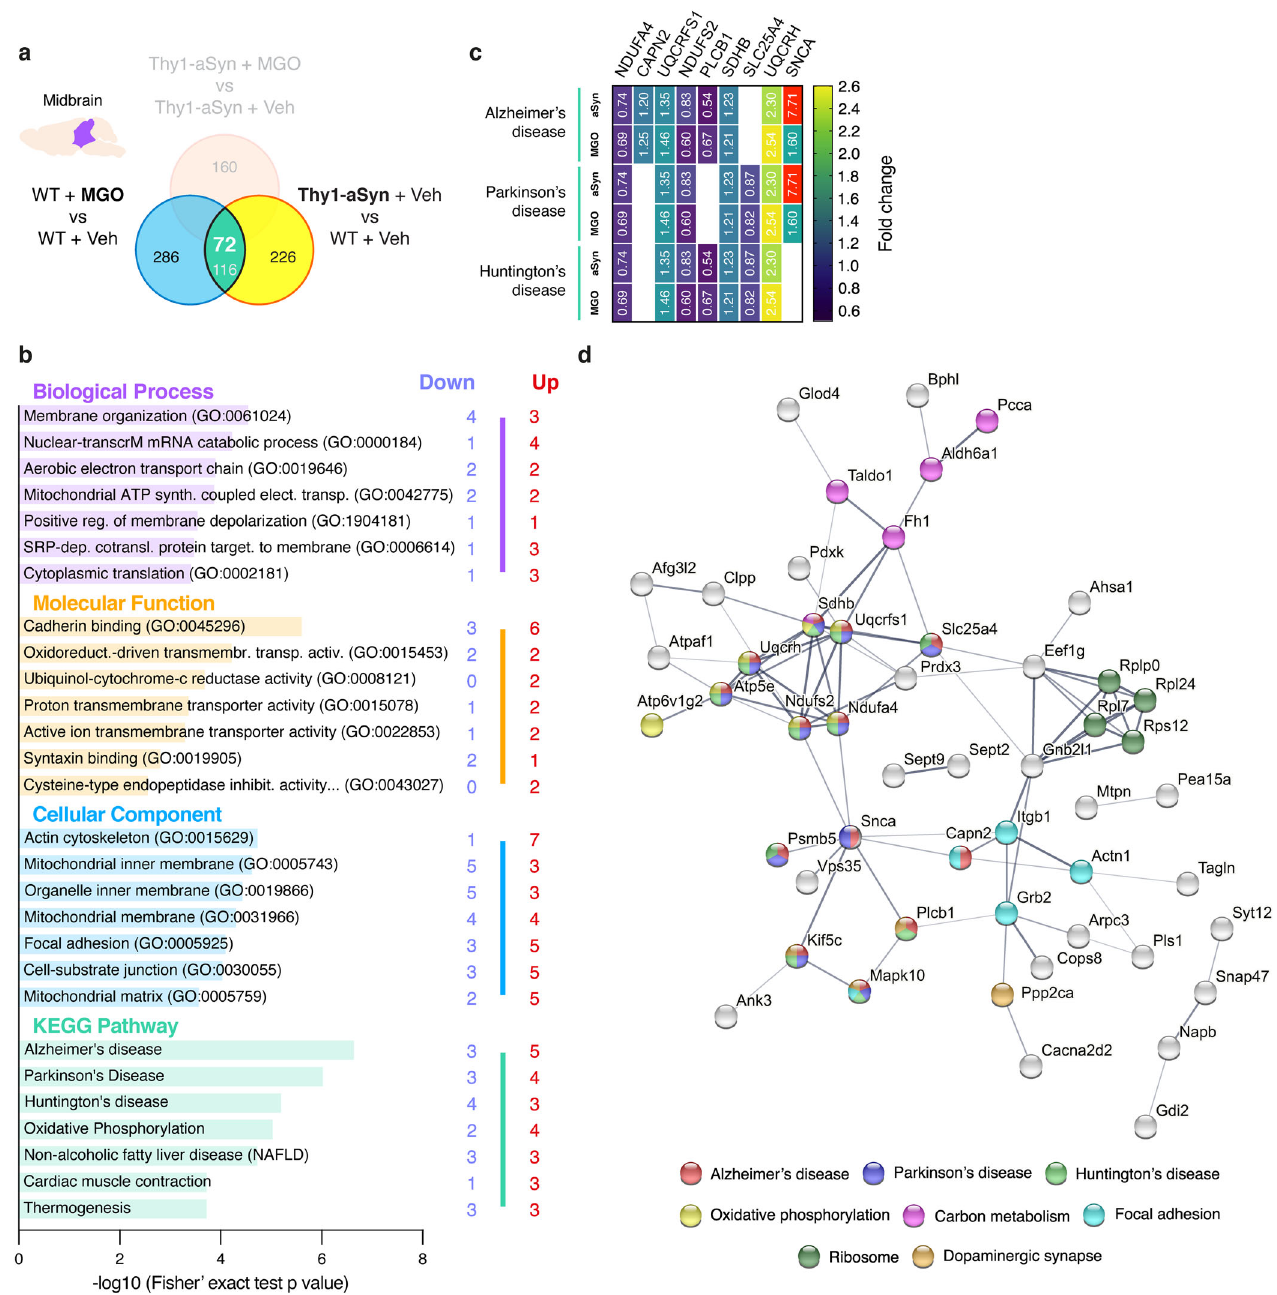
Fig. 8 MGO-treatment and aSyn overexpression similarly alters neurodegenerative- and oxidative phosphorylation-associated components in the midbrain. Proteomic differences between midbrain proteins from WT or Thy1-aSyn mice injected with vehicle or MGO. a Venn diagram depicting midbrain proteome alterations between pairwise comparisons of MGO vs Vehicle-injected WT mice and Thy1-aSyn vs WT mice both injected with vehicle. From the identi fi ed 116 proteins, 72 are altered in the same direction (up- or downregulated). b KEEG pathways and Gene Ontology (GO) terms analysis is presented for the commonly altered proteins, depicting the number of down- and upregulated unique hits. Distribution of − log 10 (Fisher exact test p value) is shown. c Heatmap of the commonly altered proteins corresponding to the top 3 altered KEGG pathways is presented per each pairwise comparison (aSyn — vehicle-Thy1-aSyn vs vehicle- WT; MGO — MGO-WT vs Veh-MGO). d Protein – protein interaction networks of the commonly altered proteins, extracted from the STRING 11.0 database. Only the proteins that are interacting within a network are show. KEGG pathways or GO Biological processes are color hallmark among different neurodegenerative disorders, we posit that glycation may modulate the aggregation and toxicity of the different aggregation-prone proteins and that it may unveil novel targets for therapeutic intervention.